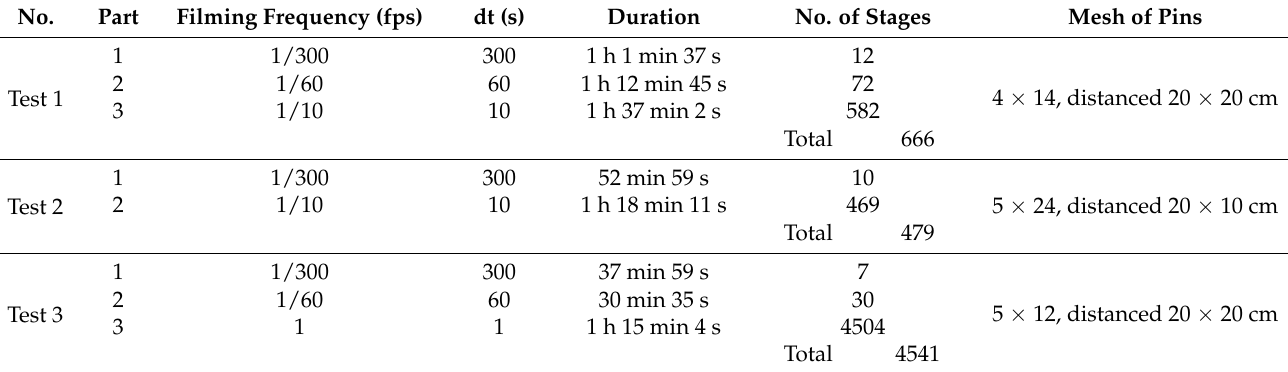
Table 9. Duration and frequency of filming by high-speed cameras used in